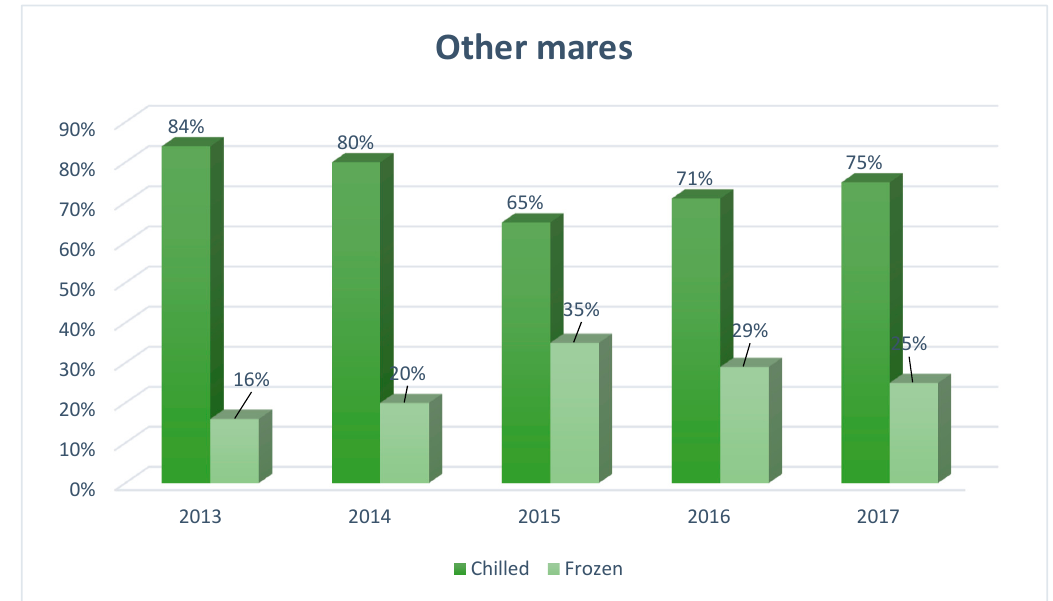
Figure 3. The structure of insemination of other mares in Europe, including the division into the type of semen used for artificial insemination ( N = 2480), developed based on reports from European insemination stations.